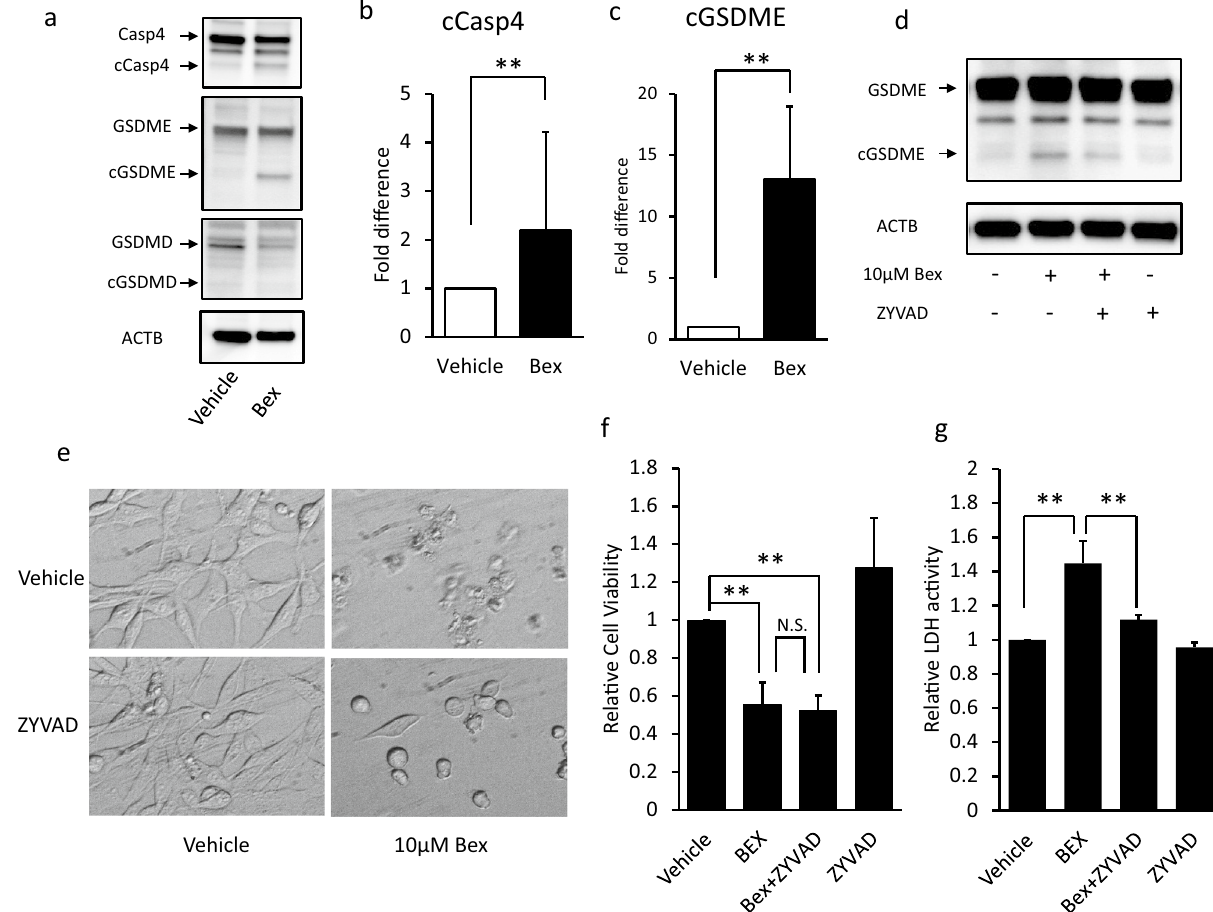
Figure 3. Bexarotene induces pyroptosis in ES2 cells. ( a ) Bexarotene increased pyroptosis-related proteins (Casp4, GSDME, and GSDMD) following exposure with 10 µM of bexarotene for 24 h in ES2 cells. Bexarotene increased cleaved caspase-4 levels ( b ) and cleaved GSDME levels ( c ). Β-actin was used as an internal control. ( d ) ZYVAD-FMK treatment reduced the levels of cleaved GSDME 4 h following bexarotene treatment. ES2 cells were pretreated with or without 10 µM–ZYVAD-FMK (caspase-4 inhibitor) 1 h before 10-µM-bexarotene treatment. ( e ) Bexarotene-treated cells showed pyroptotic-like morphological changes (upper right panel), whereas pretreatment with ZYVAD-FMK attenuated bexarotene-induced cell shape alteration (lower right panel). ( f ) Cell numbers were manually counted 24 h after bexarotene treatment, and cell viability against the bexarotene nontreated group was calculated. Pretreatment with ZYVAD-FMK could not suppress bexarotene- induced cell viability reduction. ( g ) The extracellular LDH levels increased by bexarotene were reduced by pretreatment with ZYVAD-FMK. Columns and bar graphs represent the mean ± standard deviation for at least three independent experiments. ** P < 0.01. Casp, Caspase; ACTB, β-actin; cGSDME, cleaved GSDME; cGSDMD, cleaved GSDMD; ZYVAD-FMK, ZYVAD; LDH, lactate dehydrogenase; N.S., not